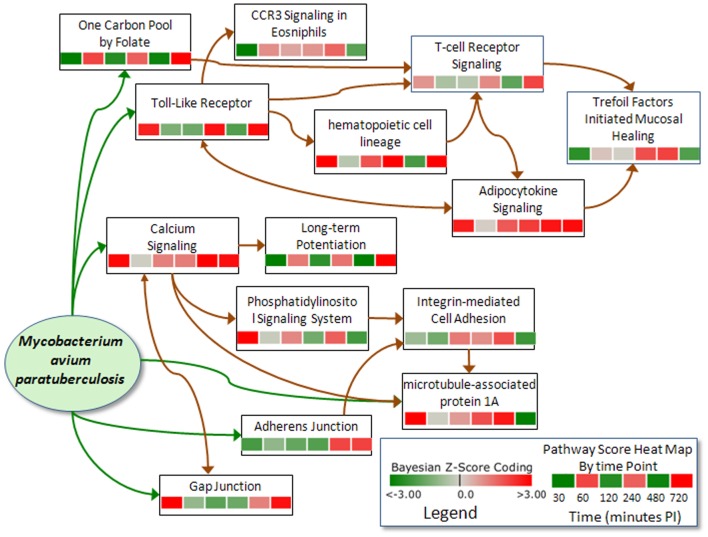
High Level Conceptual Systems Network of Interrelated Pathways further Defining the Bovine Host Immune Tolerance to MAP.Each box that defines specific pathways has its temporal heat map scores to document the dynamic state of the pathway (see figure legend). The arrows connecting the pathways are drawn to represent possible causal relationships between the pathways.